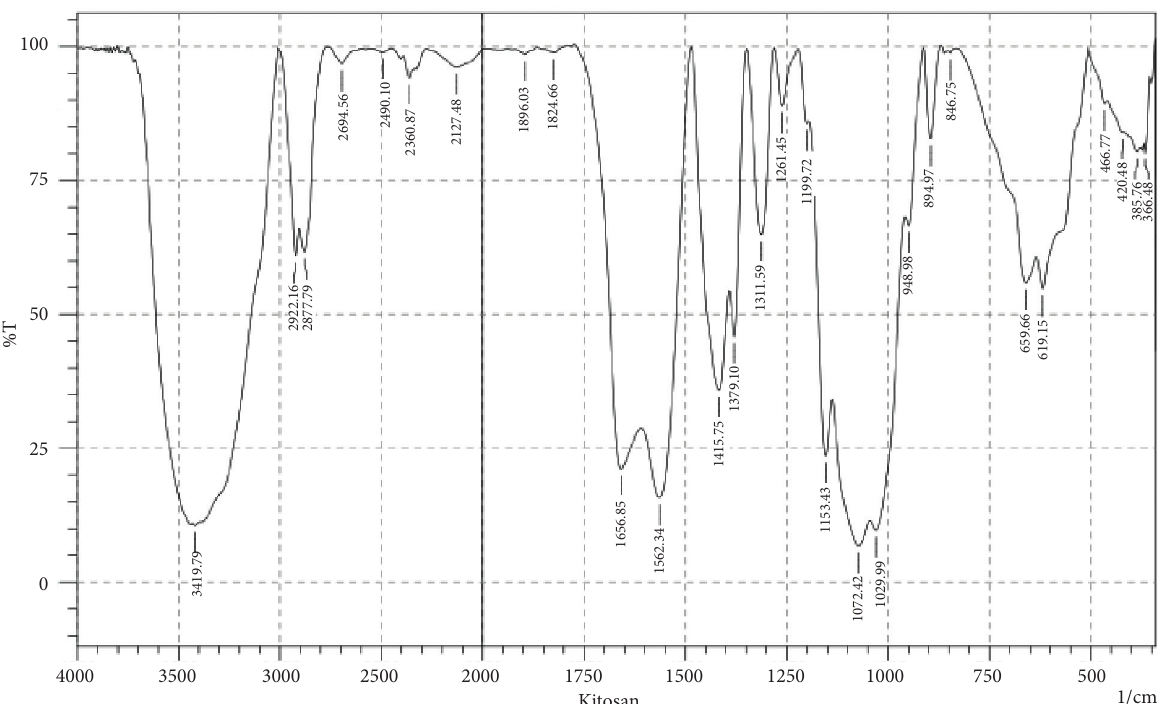
Figure 1: FTIR spectrum of crab ( portunus pelagicus ) shell chitosan gel.